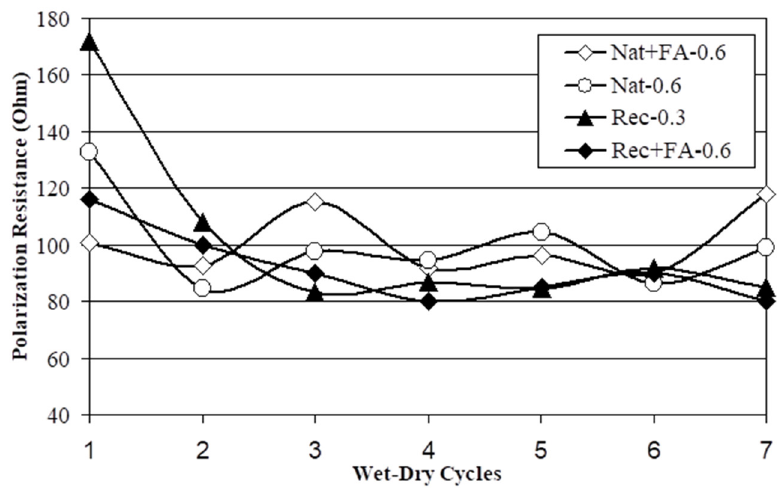
Figure 9. Polarization resistance of galvanized steel plates in cracked concrete vs. wet–dry cycles.